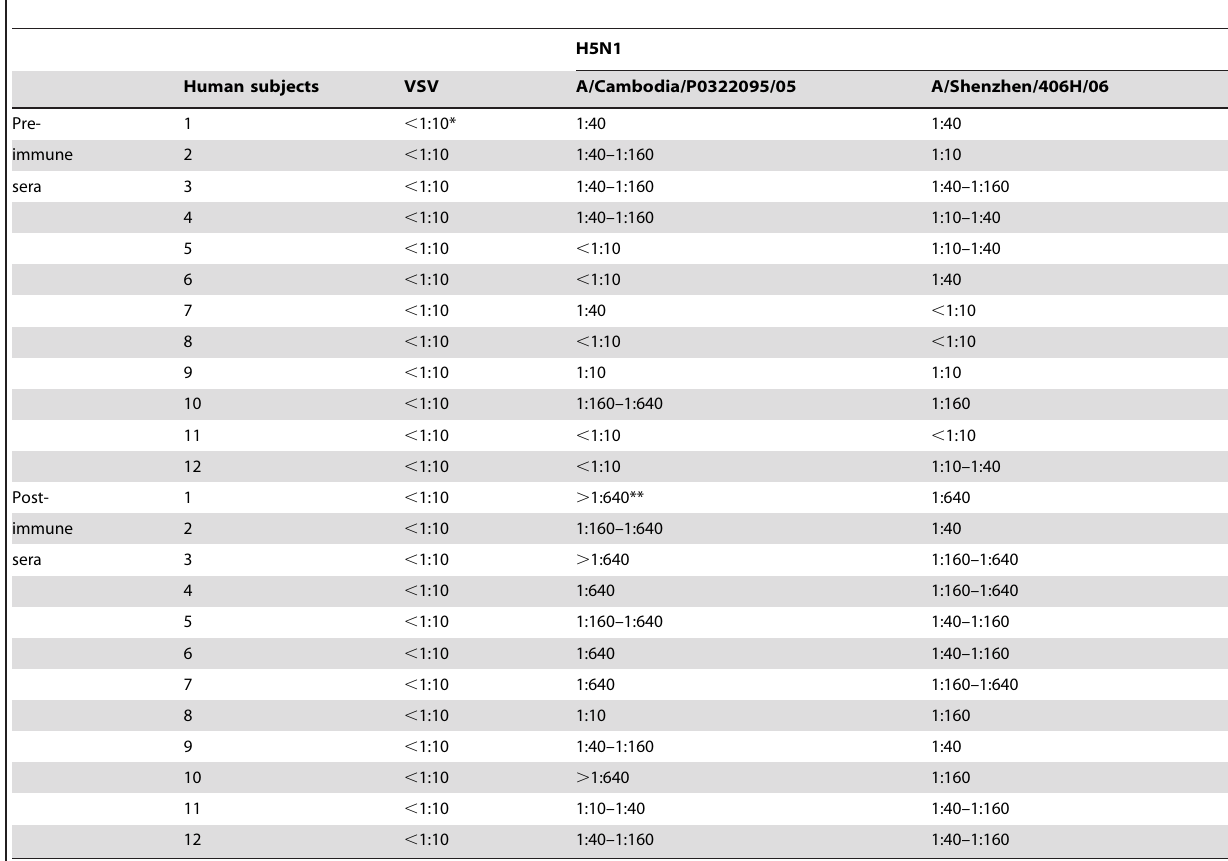
Table 4. Neutralizing antibody titers in pre- and post-immune sera measured by PN (release/entry) assay.